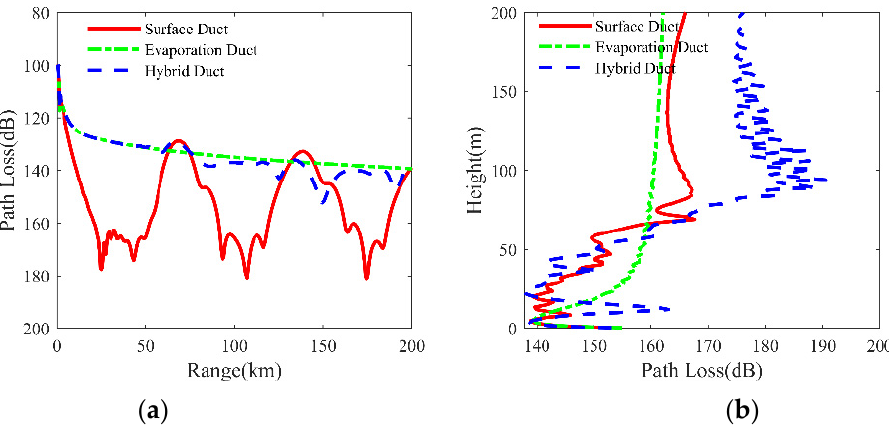
Figure 11. Path loss changes with distance and height: ( a ) at a receiving height of 5 m; and ( b ) at a receiving distance of 200 km.